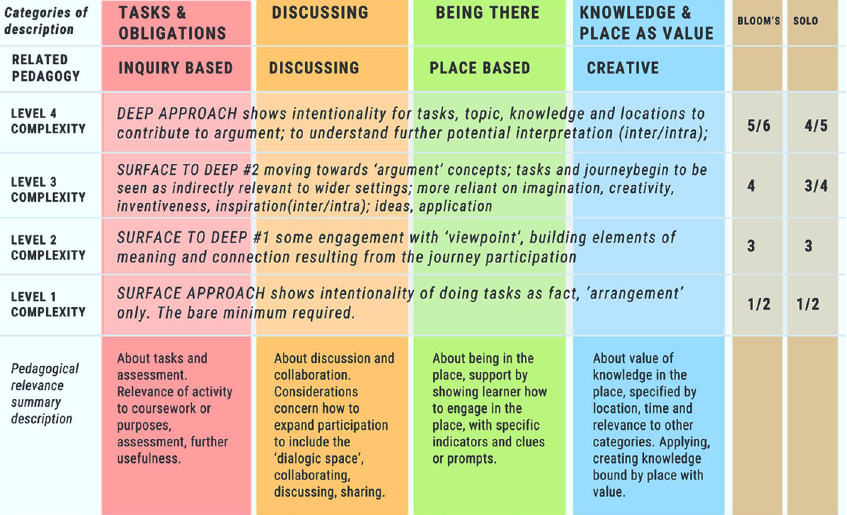
Fig. 1 PECSL ‘Grid’ showing experience complexity alignment with learning evaluation descriptors and learning taxonomy